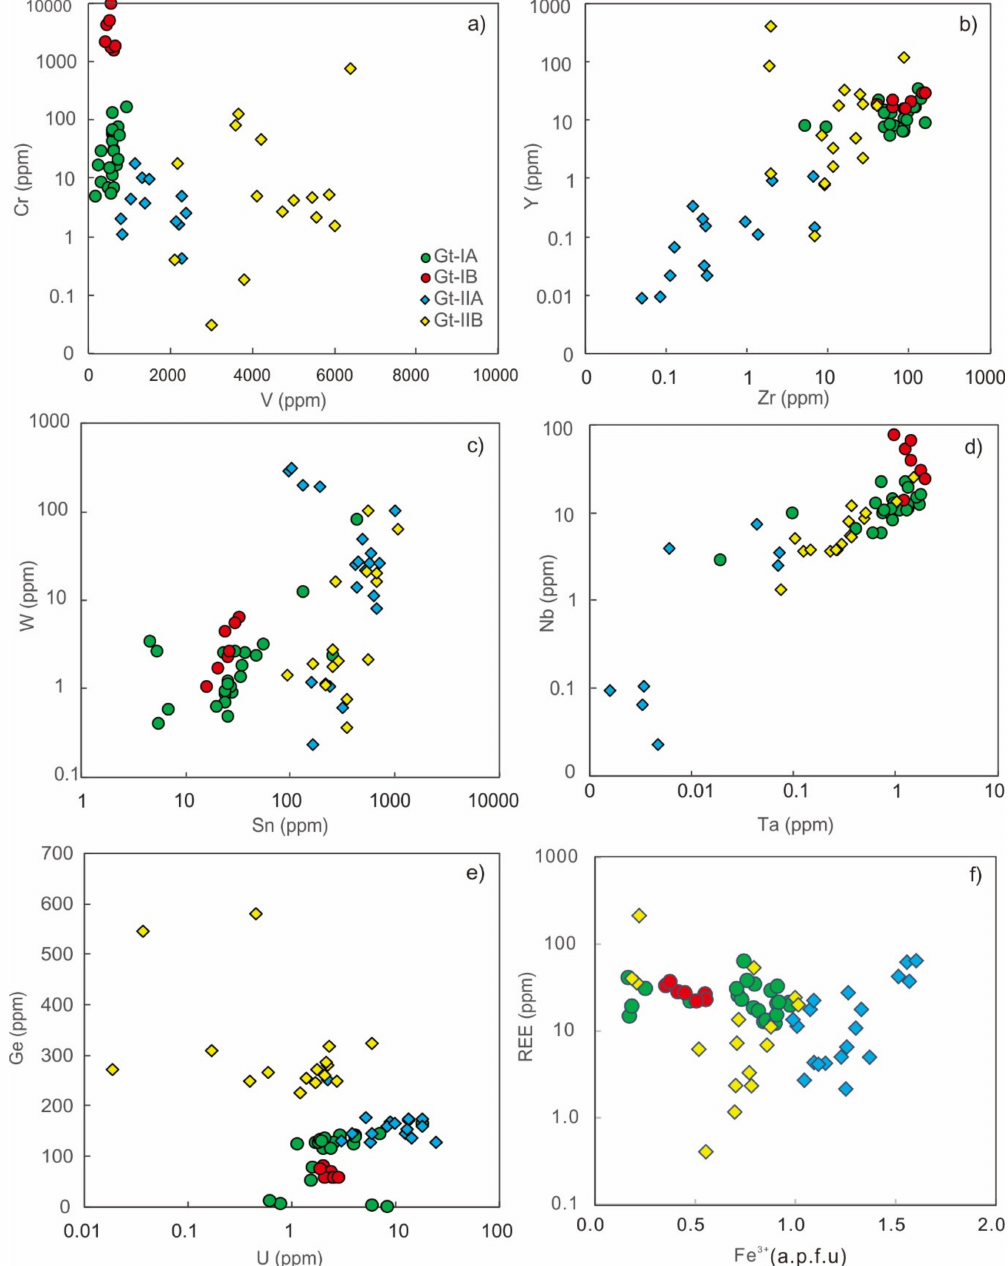
Figure 6. Trace element diagrams of di ff erent types of garnets from the Zhuxiling W (Mo) deposit. ( a ) Cr (ppm) versus V(ppm) plot; ( b ) Zr (ppm) versus Y (ppm) plot; ( c ) Sn (ppm) versus W (ppm)